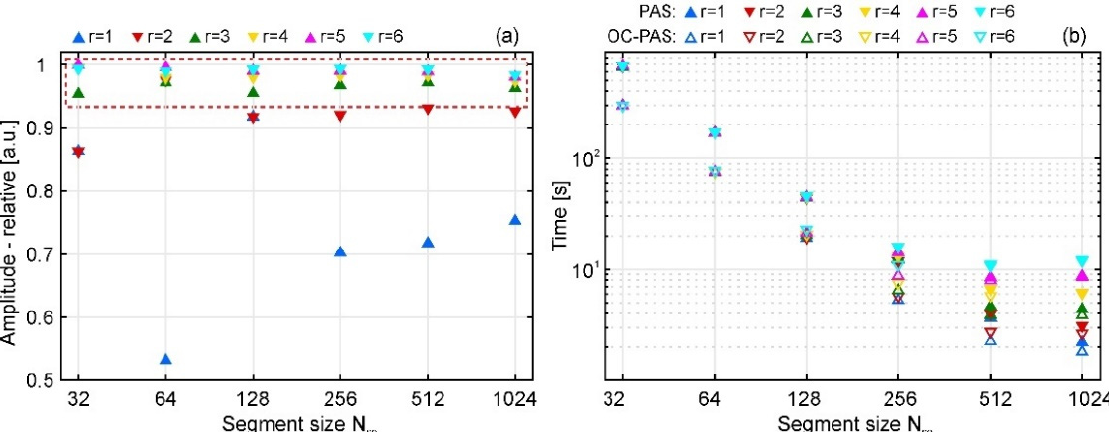
Figure 6. ( a ) Normalized reconstructed amplitude of P 10 for different N so and r ; ( b ) Reconstruction time for a CGH of 1 million points for different segment N so and factors r without (PAS) and with (OC-PAS) occlusion culling.